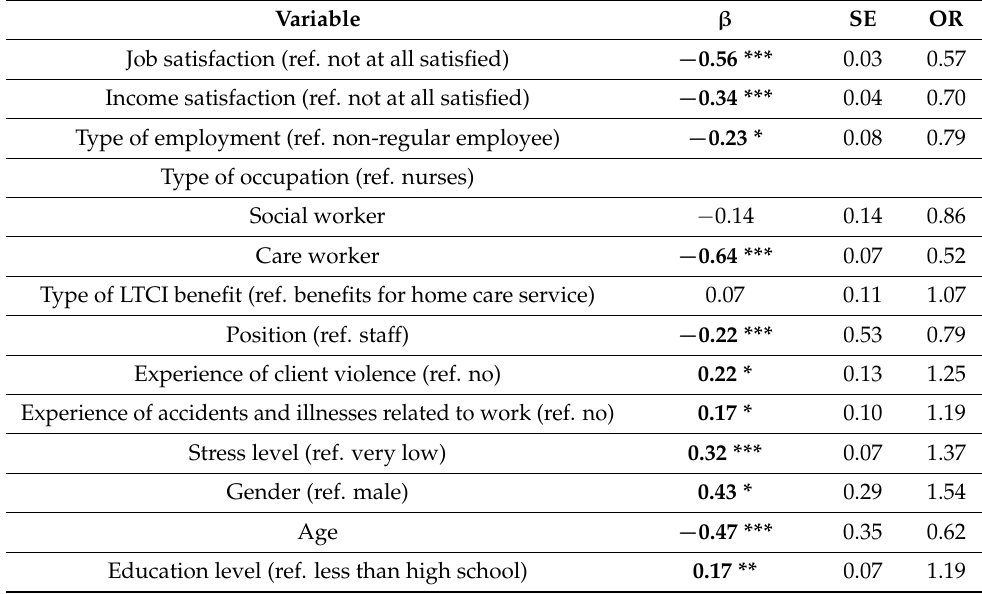
Table 5. Factors influencing turnover intention ( n = 3541). Variable β SE OR Job satisfaction (ref. not at all satisfied) − 0.56 *** 0.03 0.57 Income satisfaction (ref. not at all satisfied) − 0.34 *** Type of employment (ref. non-regular employee) − 0.23 * Type of occupation (ref. nurses) Social